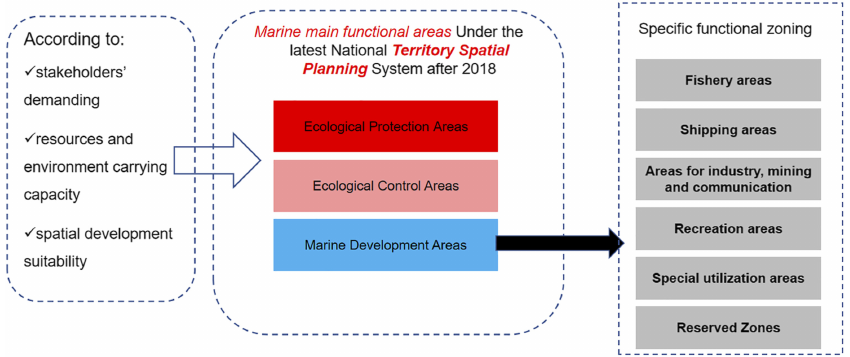
Figure 3. Redefinition of marine main function areas in new planning